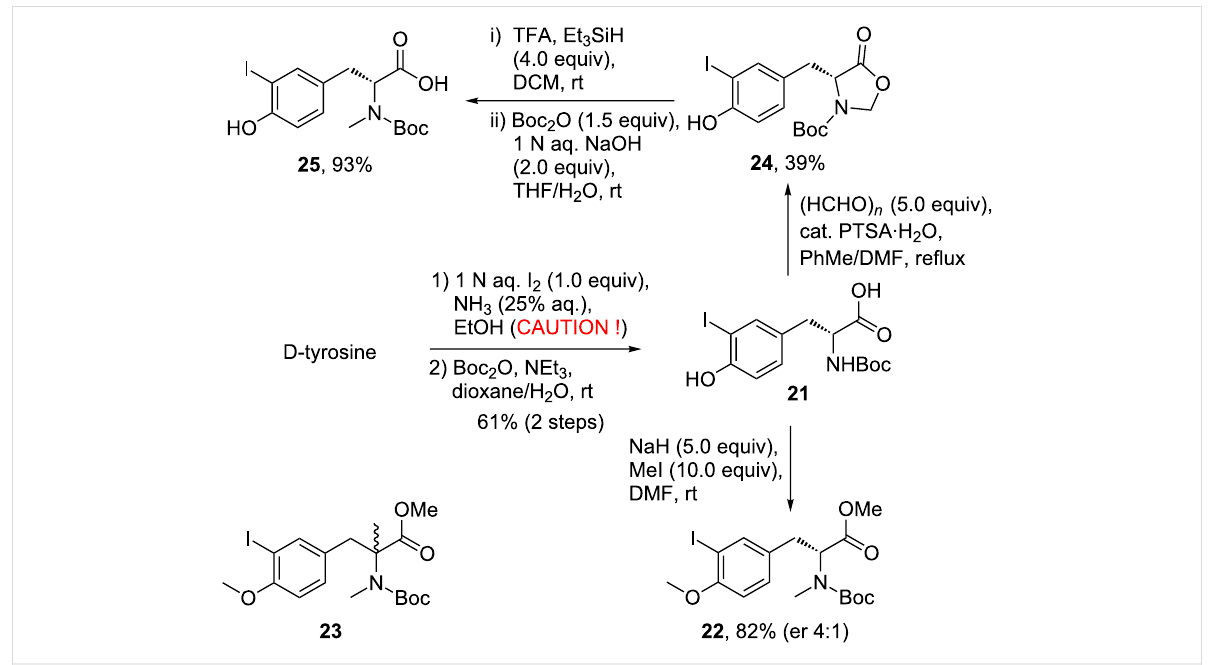
Scheme 4: Access to methylated D-iodotyrosine derivatives 22 , 23 , and 25